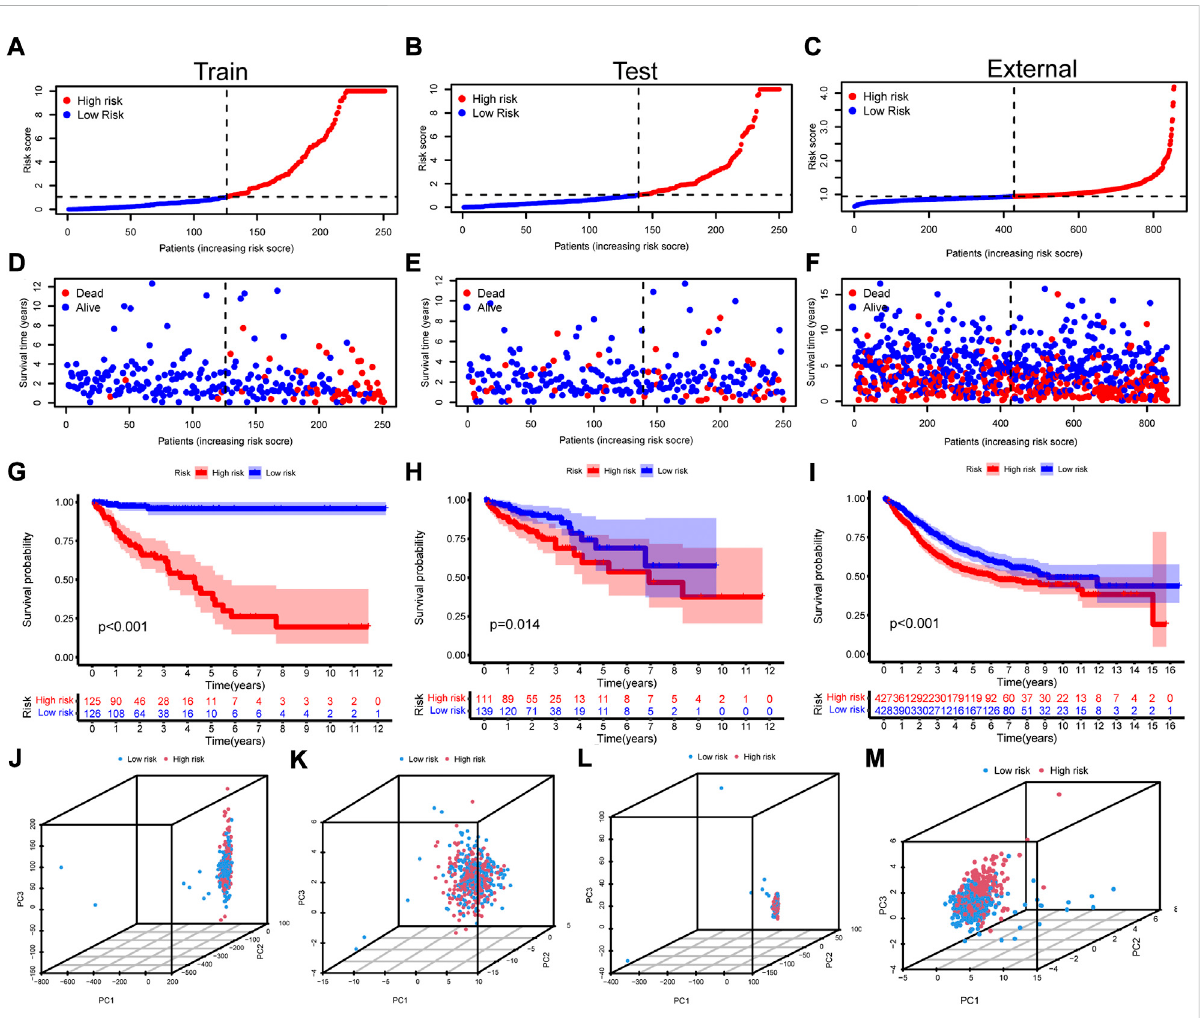
FIGURE 3 Constructionofthecuproptosis-related prognosismodel. (A-C) The scatterplot of riskscore inthetrain set,testset, andtheexternal validation set, respectively. (D-F) The distribution of survival time and survival status of high and low risk groups in the train set, test set, and the external validation set. (G-I) The Kaplan – Meier survival curves of overall survival between high and low risk groups in the train set, test set, and the external validation set. (J-M) The PCA with all genes, cuproptosis regulators, 1,111 cuproptosis-related lncRNAs and 15 model lncRNAs for all the